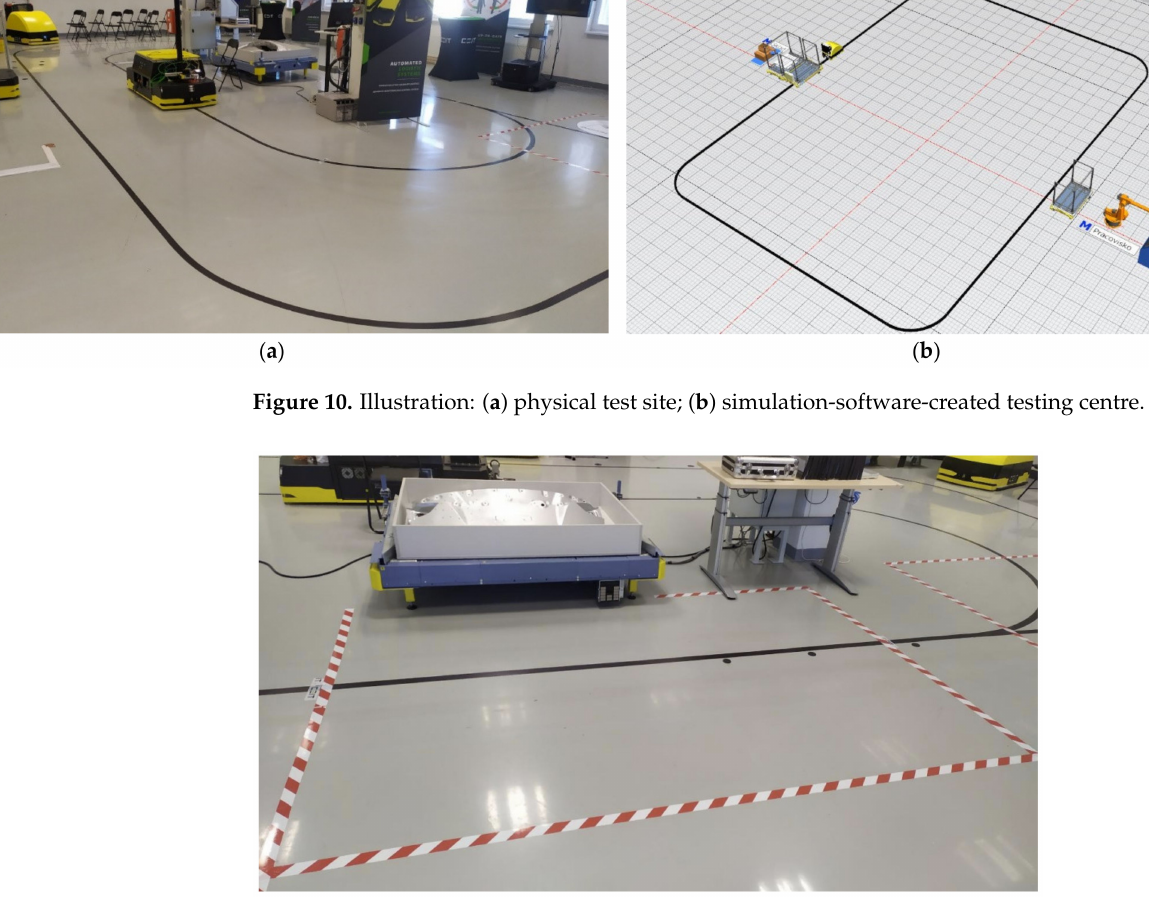
Figure 11. Position of the future workplace located on the defined tag